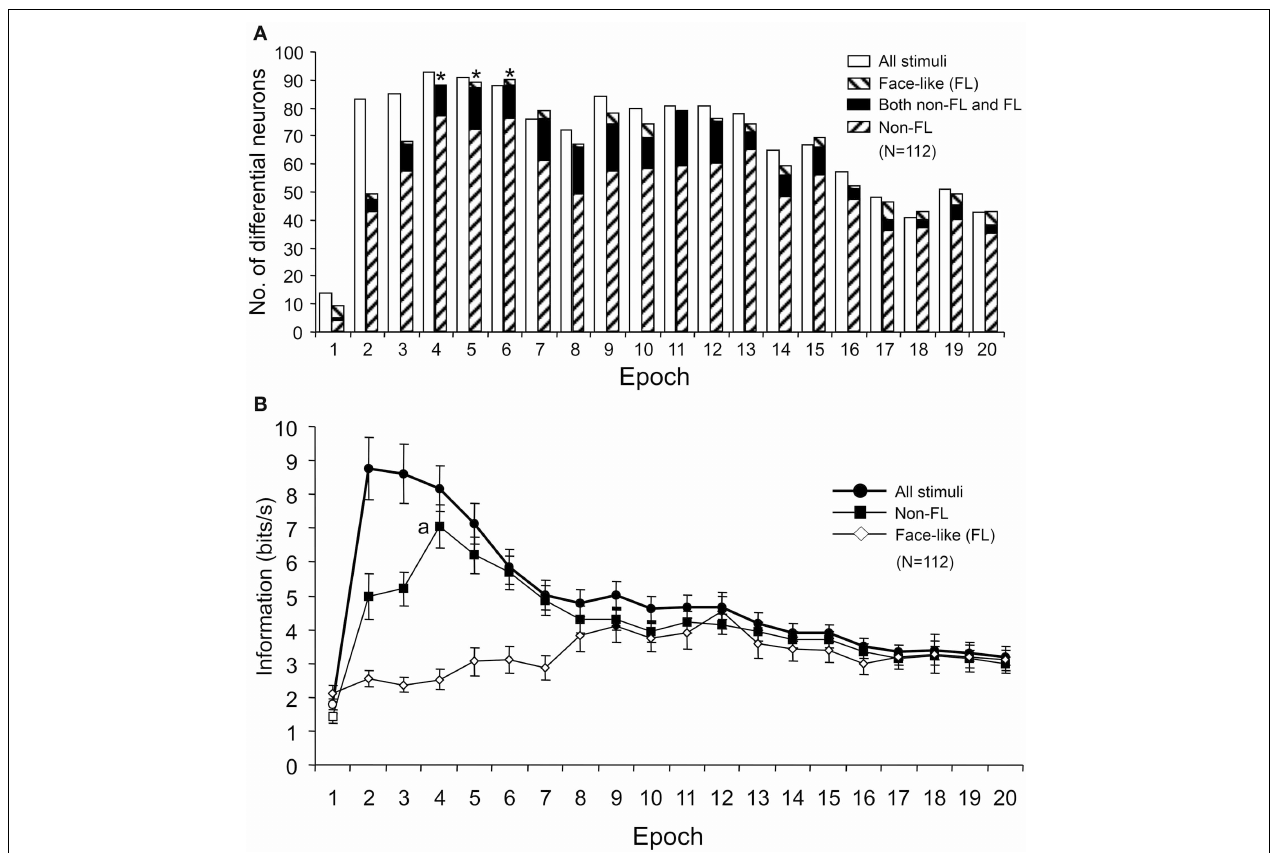
FIGURE 11 | Changes in the number of differential neurons (A) and the amount of information conveyed by the sSC neurons (B) across the 20 epochs. (A) The number of differential neurons responding to all visual stimuli and responding to stimuli other than the face-like pattern (Non-FL) increased significantly from epoch 2 compared to epoch 1. ∗ , significant difference from